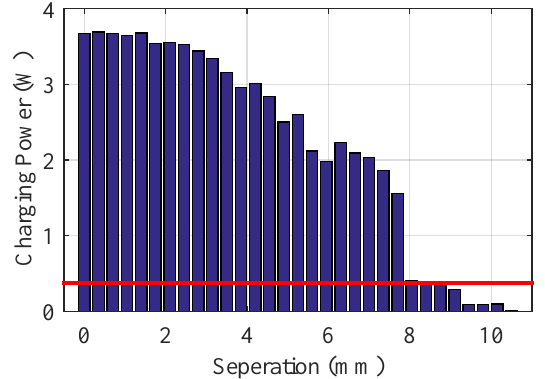
Figure 11. Charging power for various separation between the SPW-2 and the charging coil. The horizontal line indicates the maximum charging power supported by the employed